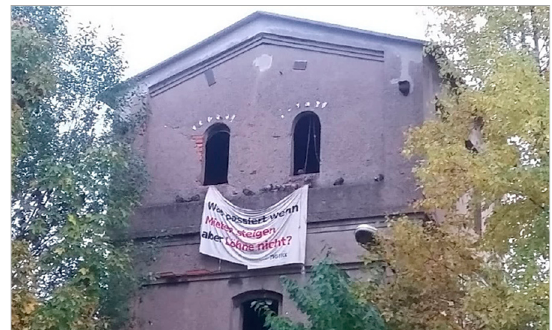
Figure 3. Billboard in Josephinenstraße: “We’re building 82 iQ apartments for students” (Photo: Lena Ali).